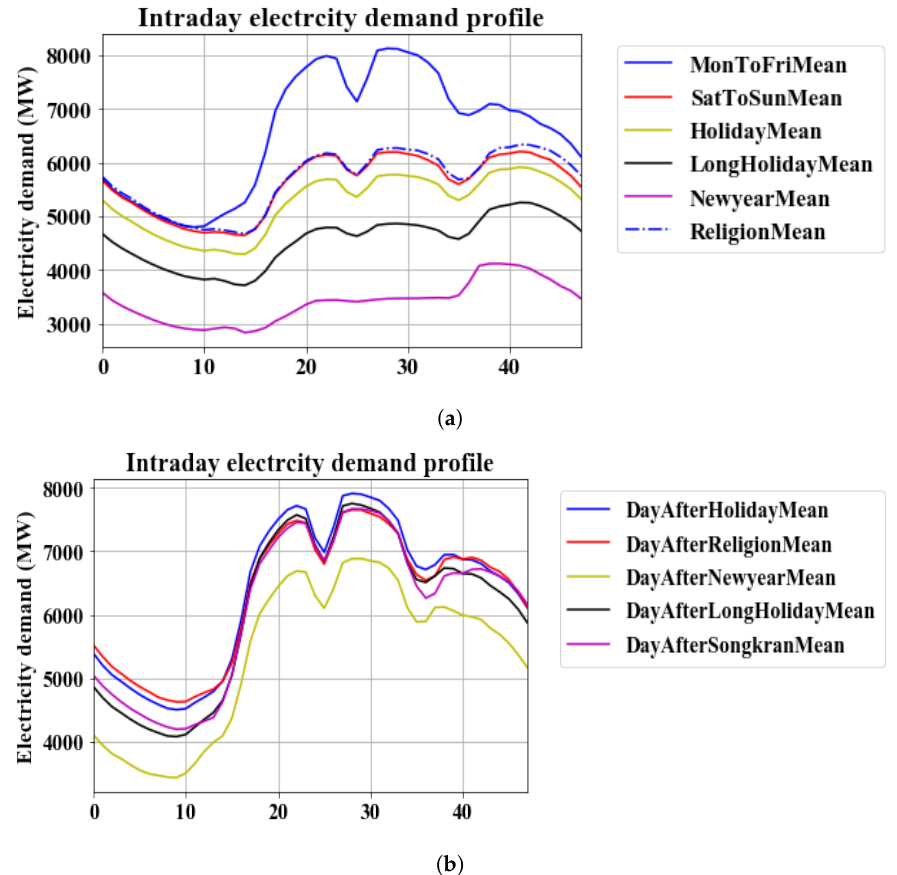
Figure A3. ( a ) Intra-day variation of demand for working and special days. ( b ) Intra-day variation of demand on the working day (next day of